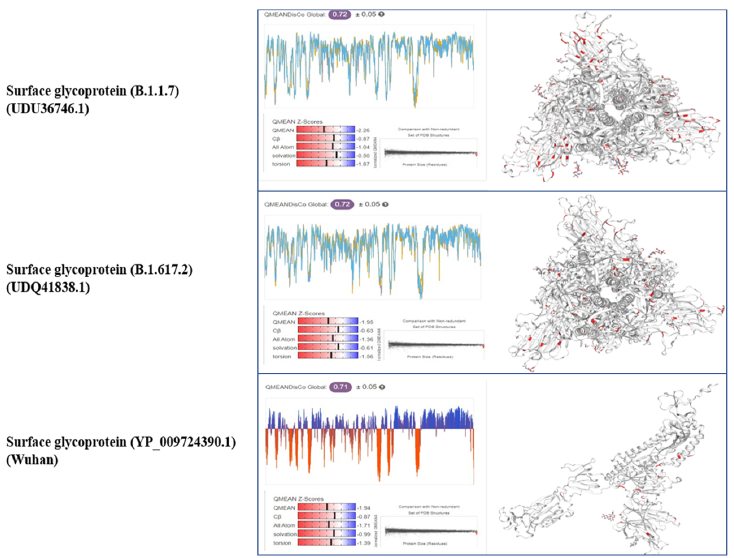
Figure 4. Comparison of the quality estimate and Cryo ‐ EM structure of PCoV_GX of the spike gly ‐ coproteins.